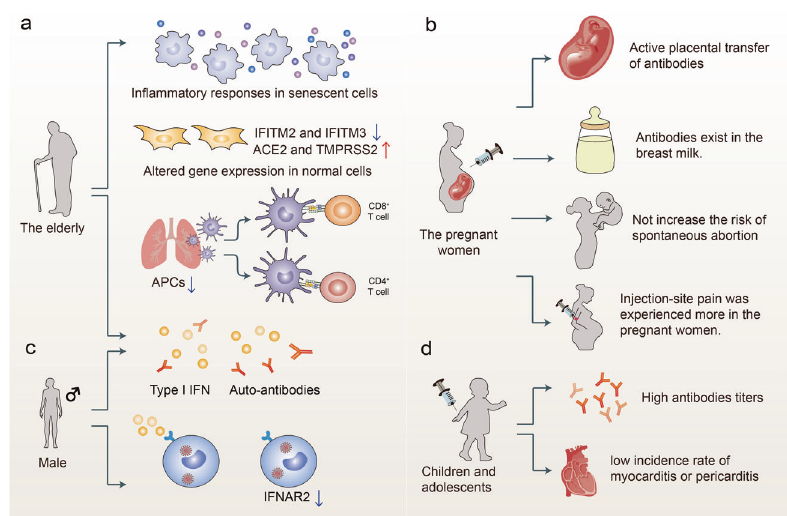
Fig. 4 Factors that may affect the immunity induced by the vaccines. a The immune responses in the elderly. In fl ammatory responses were robust in senescent cells and gene expression changed in normal cells. Immunosenescence reduces the levels of APCs and induces anti-type I interferon (IFN) autoantibodies in the elderly. b Vaccination for pregnant women. Vaccination in pregnant women is safe, with injection-site pain being frequently observed and without increasing the risk of spontaneous abortion. Moreover, vaccine-induced antibodies existed in the cord blood of infants and in the mothers ’ breast milk. c The immune responses in males. Males are prone to elicit anti-type I IFN autoantibodies, and the expression of IFNAR2 reduces. d Vaccination for children and adolescents. Vaccination for children and adolescents induced high titers of antibodies, although myocarditis and pericarditis were noticed in some young